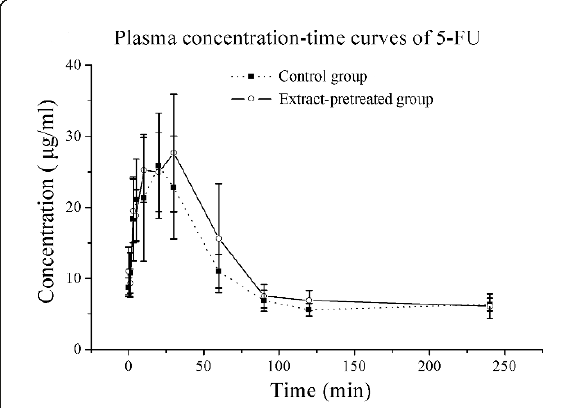
Figure 8 Plasma concentration-time curves of 5-FU . Blood samples were analyzed after a single i.p. administration of 48 mg/kg 5-FU to control rats (n = 5; black square) or rats pretreated with TC extract (1.5 ml/kg for 8 days, per os, n = 5; circle). Each value represents the mean ± SD of 5 rats.